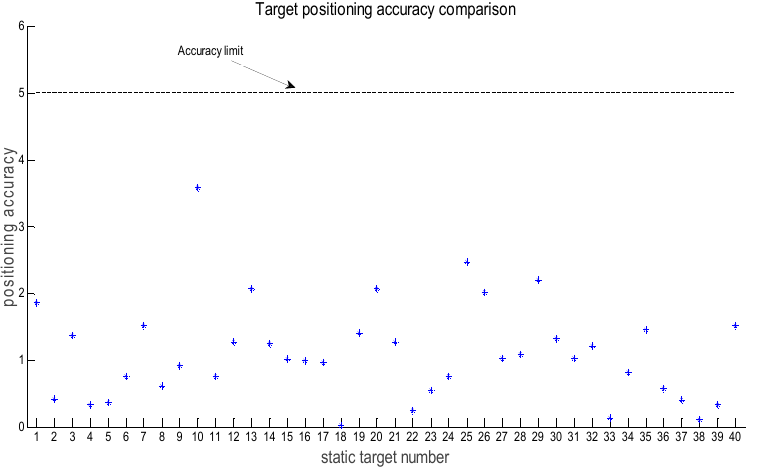
Figure 6. Targets positioning results.